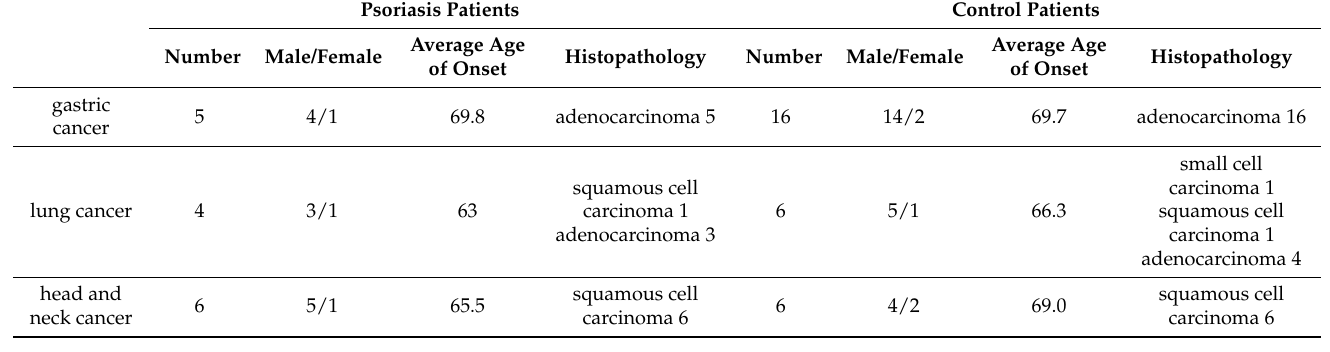
Table 2. Patients’ characteristics.